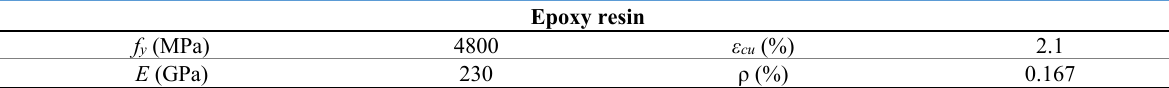
Table 4. Mechanical properties of CFRP.